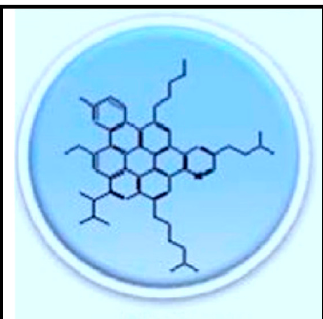
Figure 1. The asphaltene molecule consisting of PAH ring system at the core and alkanes at the periphery [2].